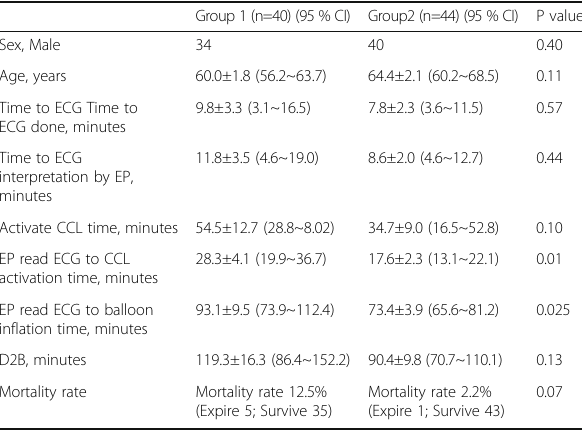
Table 69 (abstract A200). Group 1 using telephone; group 2 using